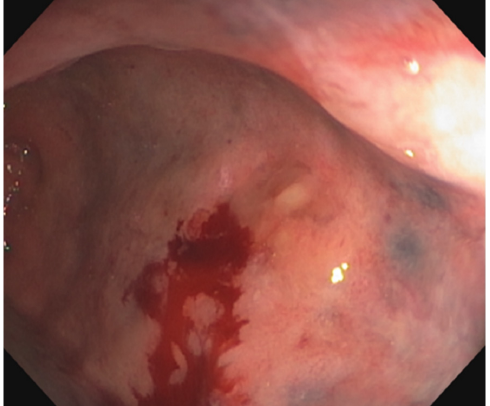
Figure 2. Endoscopy from a patient whose lesion was arising from a background of rectal fibrosis. A biopsy of this lesion demonstrated fragments of adenocarcinoma.